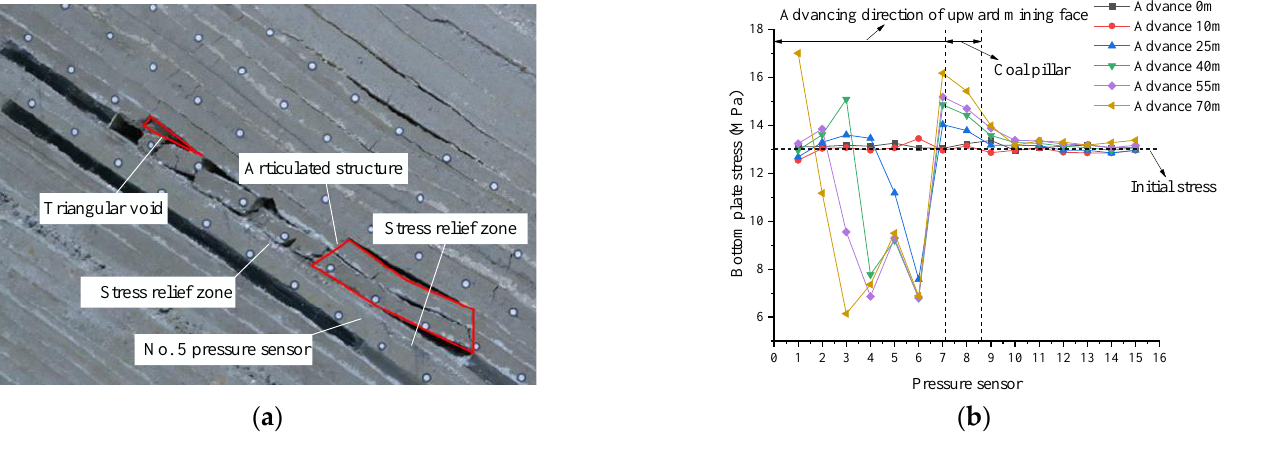
Figure 8. Stress distribution of bottom plate of overhead mining. ( a ) Mining 70 m in the upward mining face; ( b ) stress diagram of top mining floor.